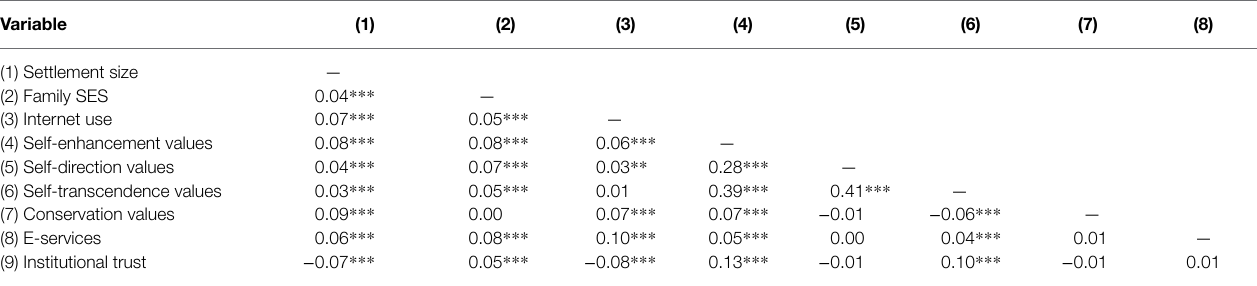
TABLE 1 | Pairwise correlations between the observed constructs on the regional level. Variable